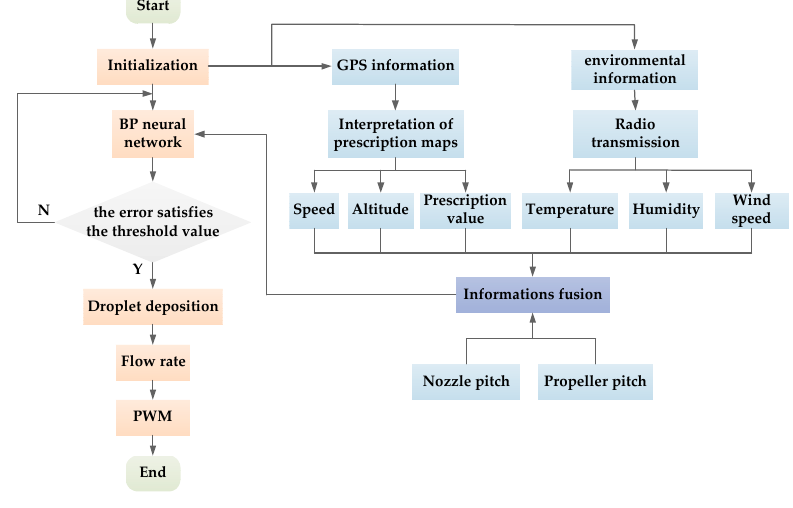
Figure 11. Program flow chart.